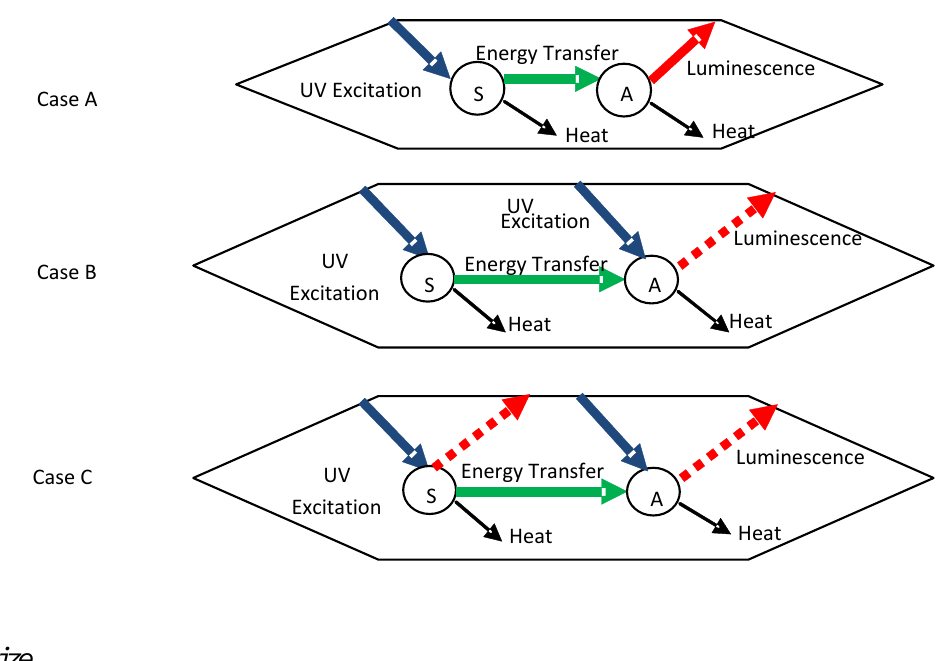
Figure 26. Examples of interactions between excitation energy, sensitizer and the activator.